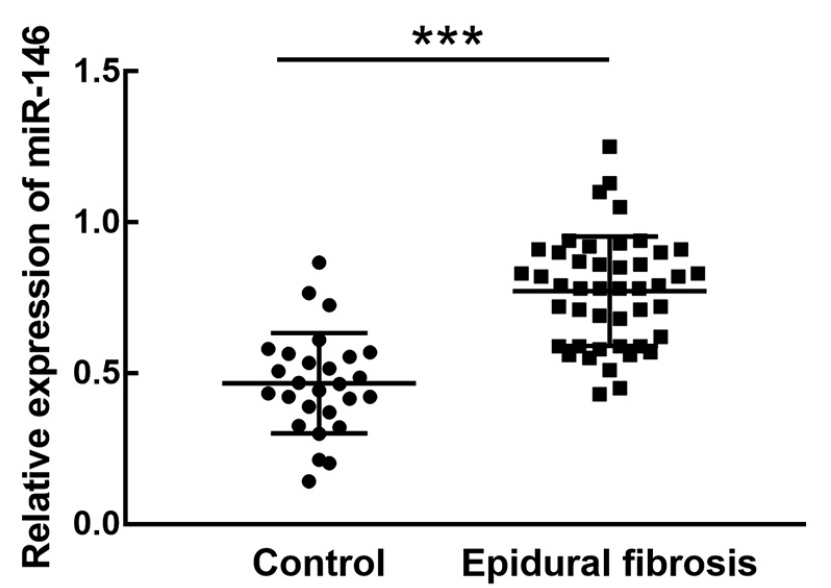
Figure 1 – The expression of miR-146 in the lumbar disc tissues of patients with or without epidural fibrosis. miR-146 was significantly upregulated in epidural fibrosis patients compared with controls. *** P < 0.001.